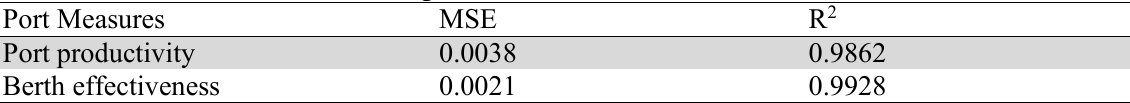
MSE and Correlation Coefficient using ARIMA Model Port